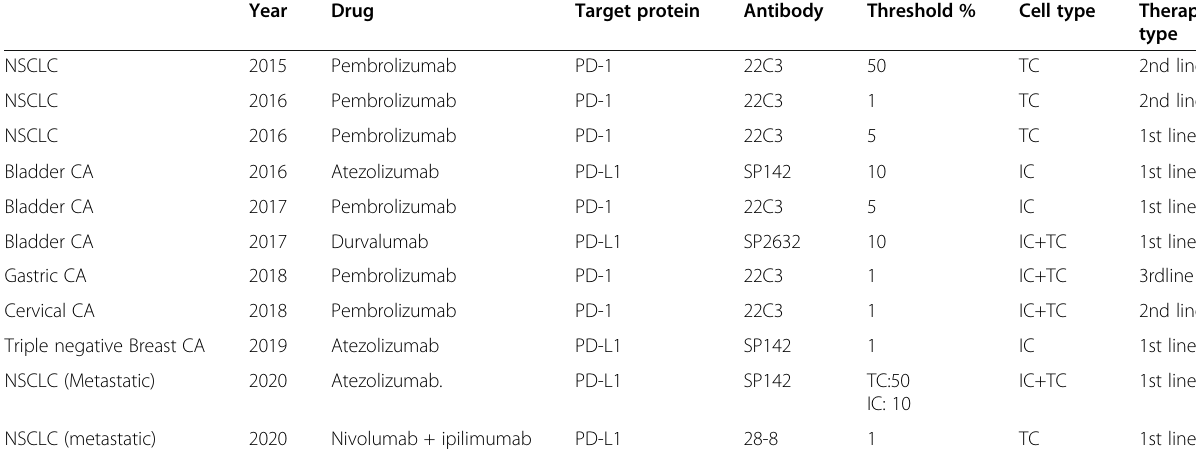
Table 1 Details of FDA-approved immune checkpoint inhibitors and corresponding antibodies for immunohistochemical staining